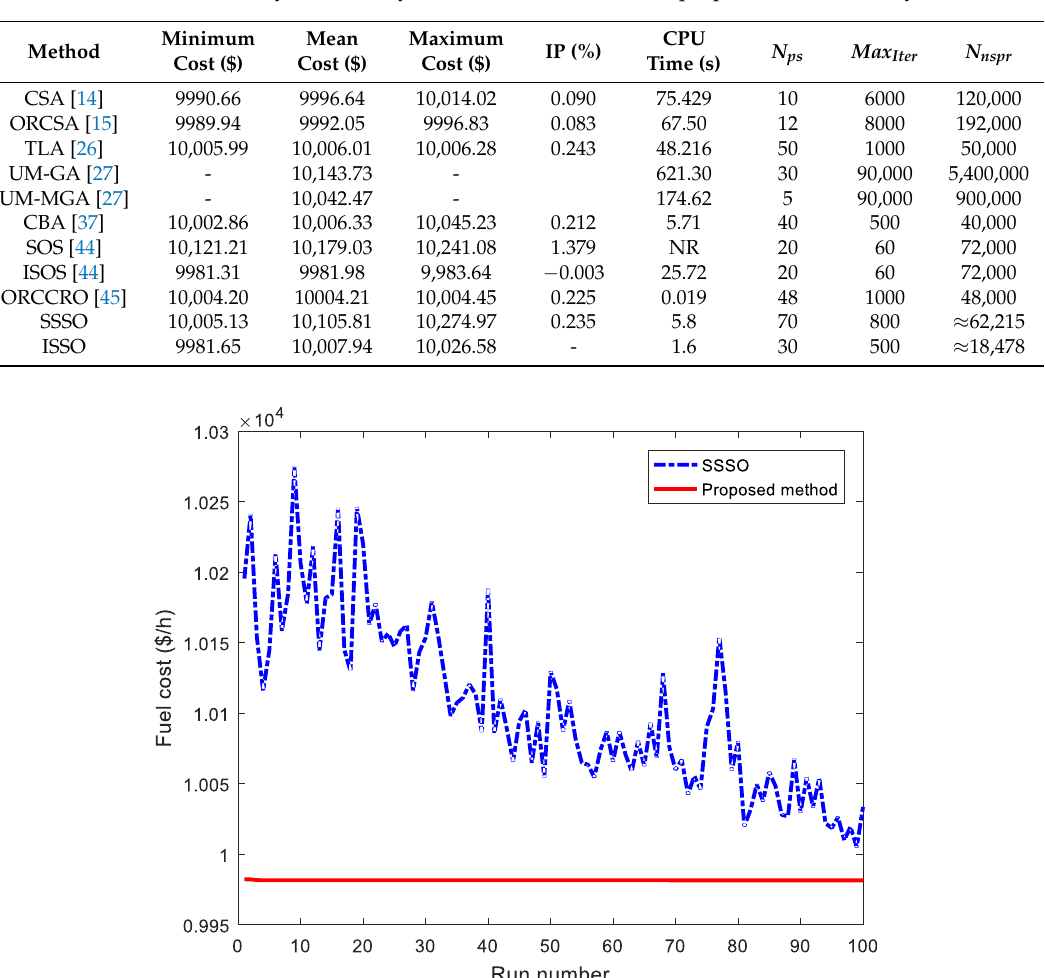
Figure 8. The best fitness functions of 100 runs obtained by SSSO and ISSO for system 5.